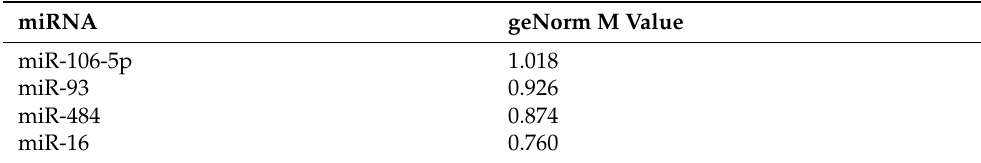
Table 2. Plasma miRNA reference panel determination using geNorm algorithm. The geNorm M value was used to measure expression stability. An M value below 1.5 indicates that miRNA is stable across samples and usable as a reference.